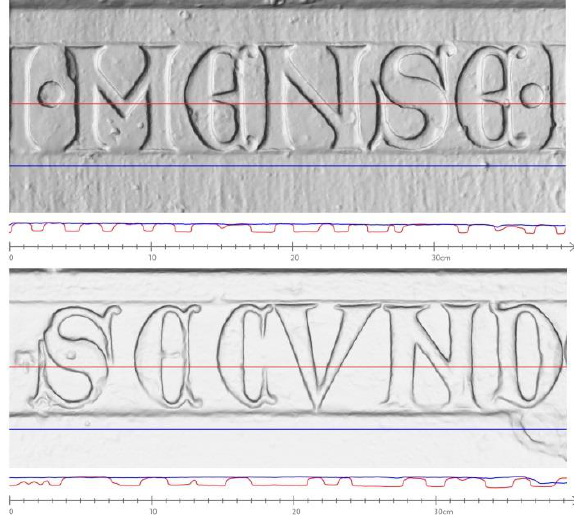
Figure 7. Horizontal cross-section, red through letters, blue base level of stone, 19 th century above, medieval below.